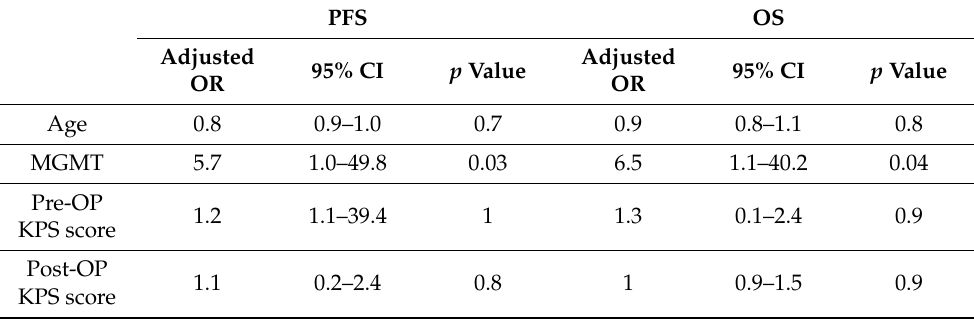
Table 2. Multivariate analysis of